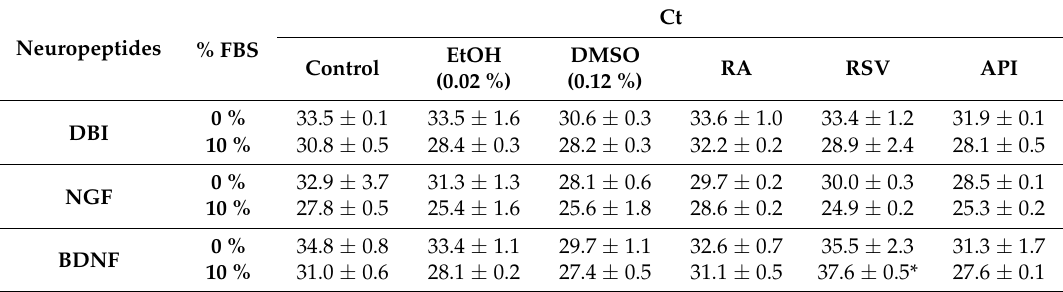
Table 1. Effects of resveratrol, apigenin, and retinoic acid on the Ct values of neuropeptides with potential neurotrophin activities: diazepam binding inhibitor (DBI; the precursor of octadecaneuropeptide (ODN)), nerve growth factor (NGF) and brain derived neurotrophic factors (BDNF). Ct % FBS Control